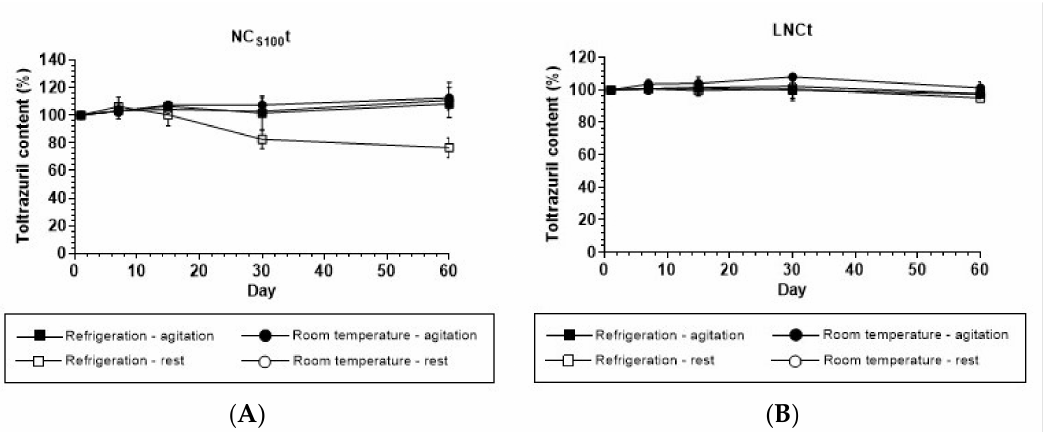
Figure 3. Toltrazuril content in ( A ) Eudragit ® S100 nanocapsules (NC S100 t) and ( B ) lipid core nanocap- sules (LNCt) submitted to room temperature (RT) and refrigeration as a function of time, with agitation or rest prior to pipetting for quantification. Values represent mean ± SD ( n =